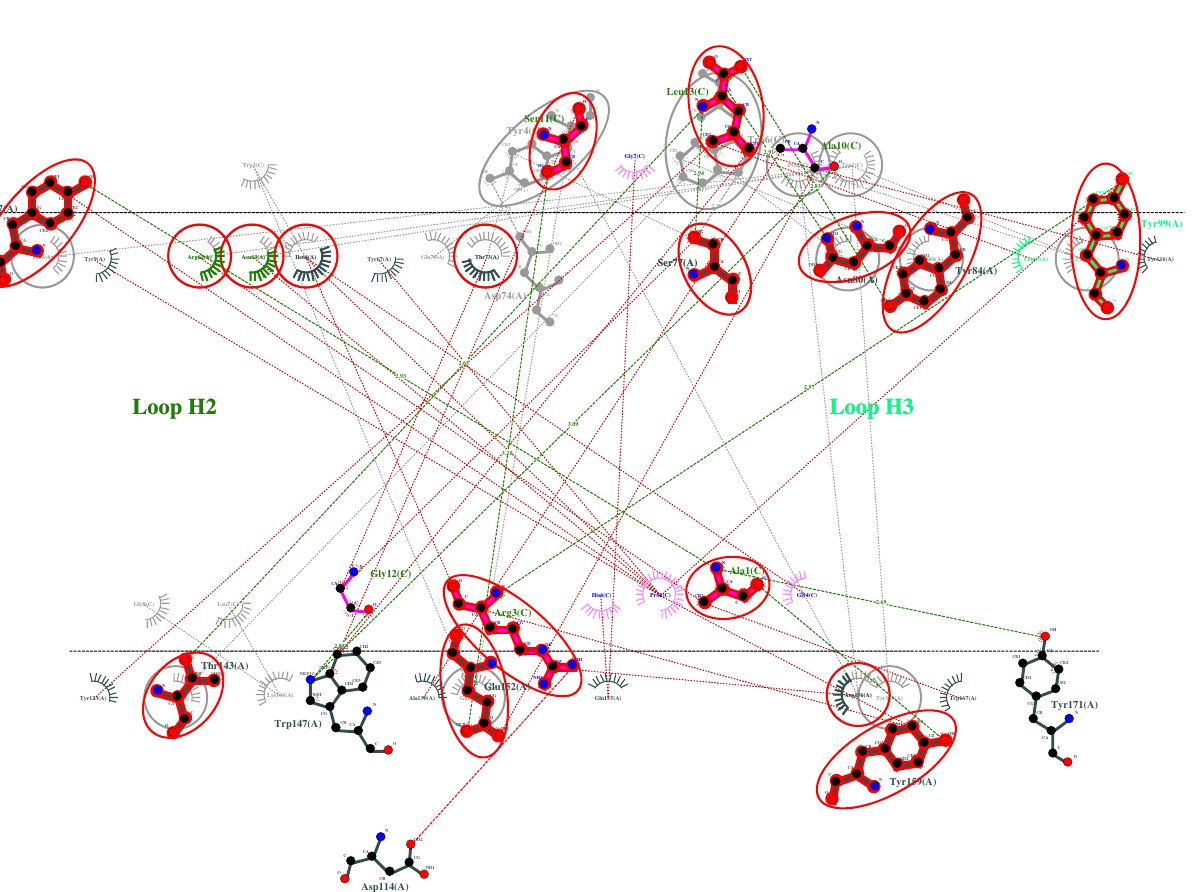
Figure 2. The interactions between HLA-B7 (PDB ID: 6AT5) and the epitope WPWYIWLGF from the SARS- CoV-2